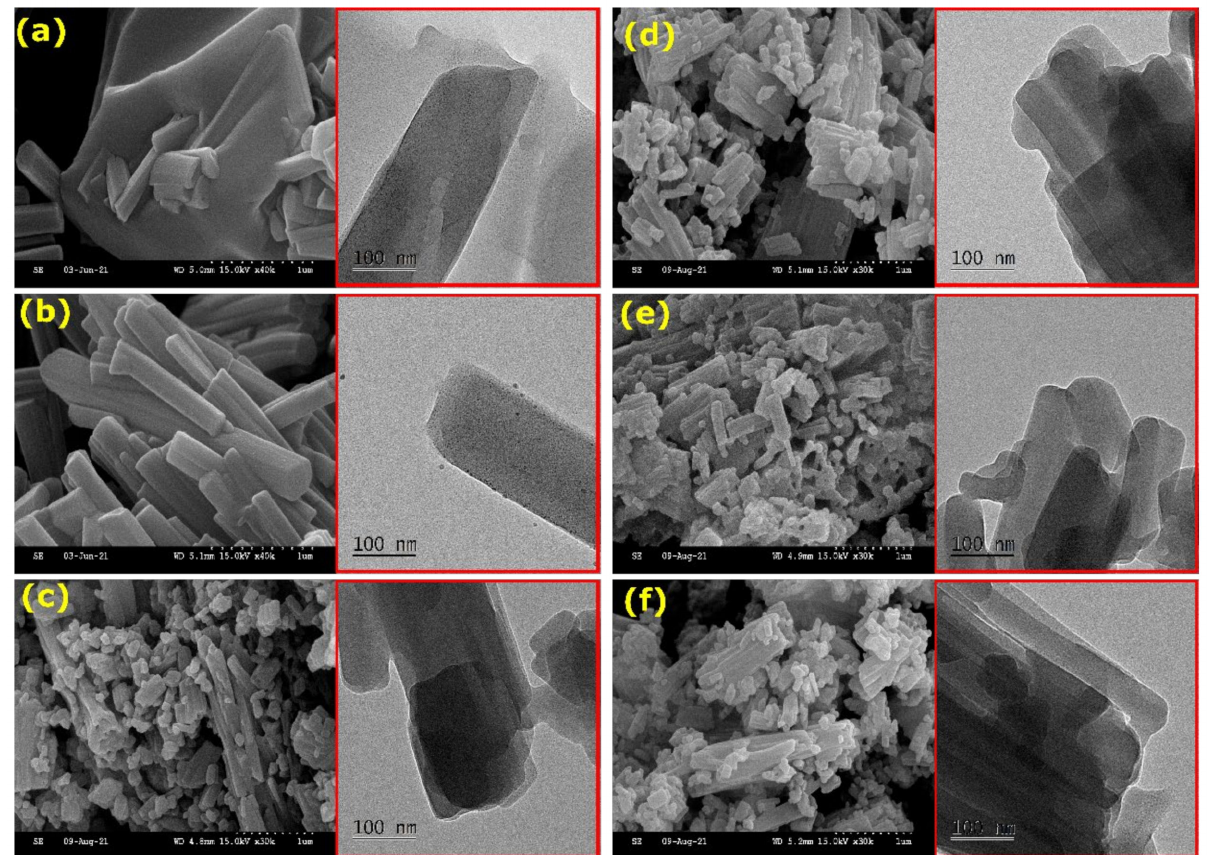
Figure 1. SEM and HR-TEM images (in red box) of ( a ) Cu-BTC; ( b ) Ag-Cu-BTC; ( c ) Ca-Cu-BTC; ( d ) Mn-Cu-BTC; ( e ) Co-Cu-BTC; ( f ) Zn-Cu-BTC. The Fourier transform infrared (FTIR) spectra have a broad intense band at 3411 cm − 1 for the v s (OH) mode of H 2 O molecules. The asymmetric (1570 and 1617 cm − 1 ) and symmetric (1383 and 1430 cm − 1 ) bands were assigned to –C=O (BTC linker). The 1710 cm − 1 band was attributed to the free –COOH groups (as confirmed by the FTIR spectrum of H 3 BTC in Figure S2) [26]. The intensity of this band increased for M-Cu-BTC (compared to Cu-BTC), which further confirmed the involvement of H 2 BTC – and HBTC 2 − spacers in the MOF framework. Multiple bands in the 1200–700 cm − 1 region, observed for C–H (Figure 2c) [27]. The isotherms and pore size distribution were analyzed by a N 2 adsorption–